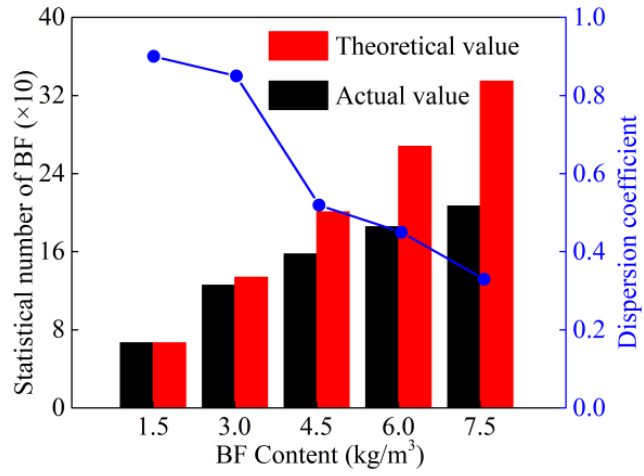
Figure 8. Dispersion coefficient of BF at different mixing ratios. Contribution index C f ( C 0 = 0, f = 0, 1.5, 3, 4.5, 6, 7.5) was defined to evaluate the gain